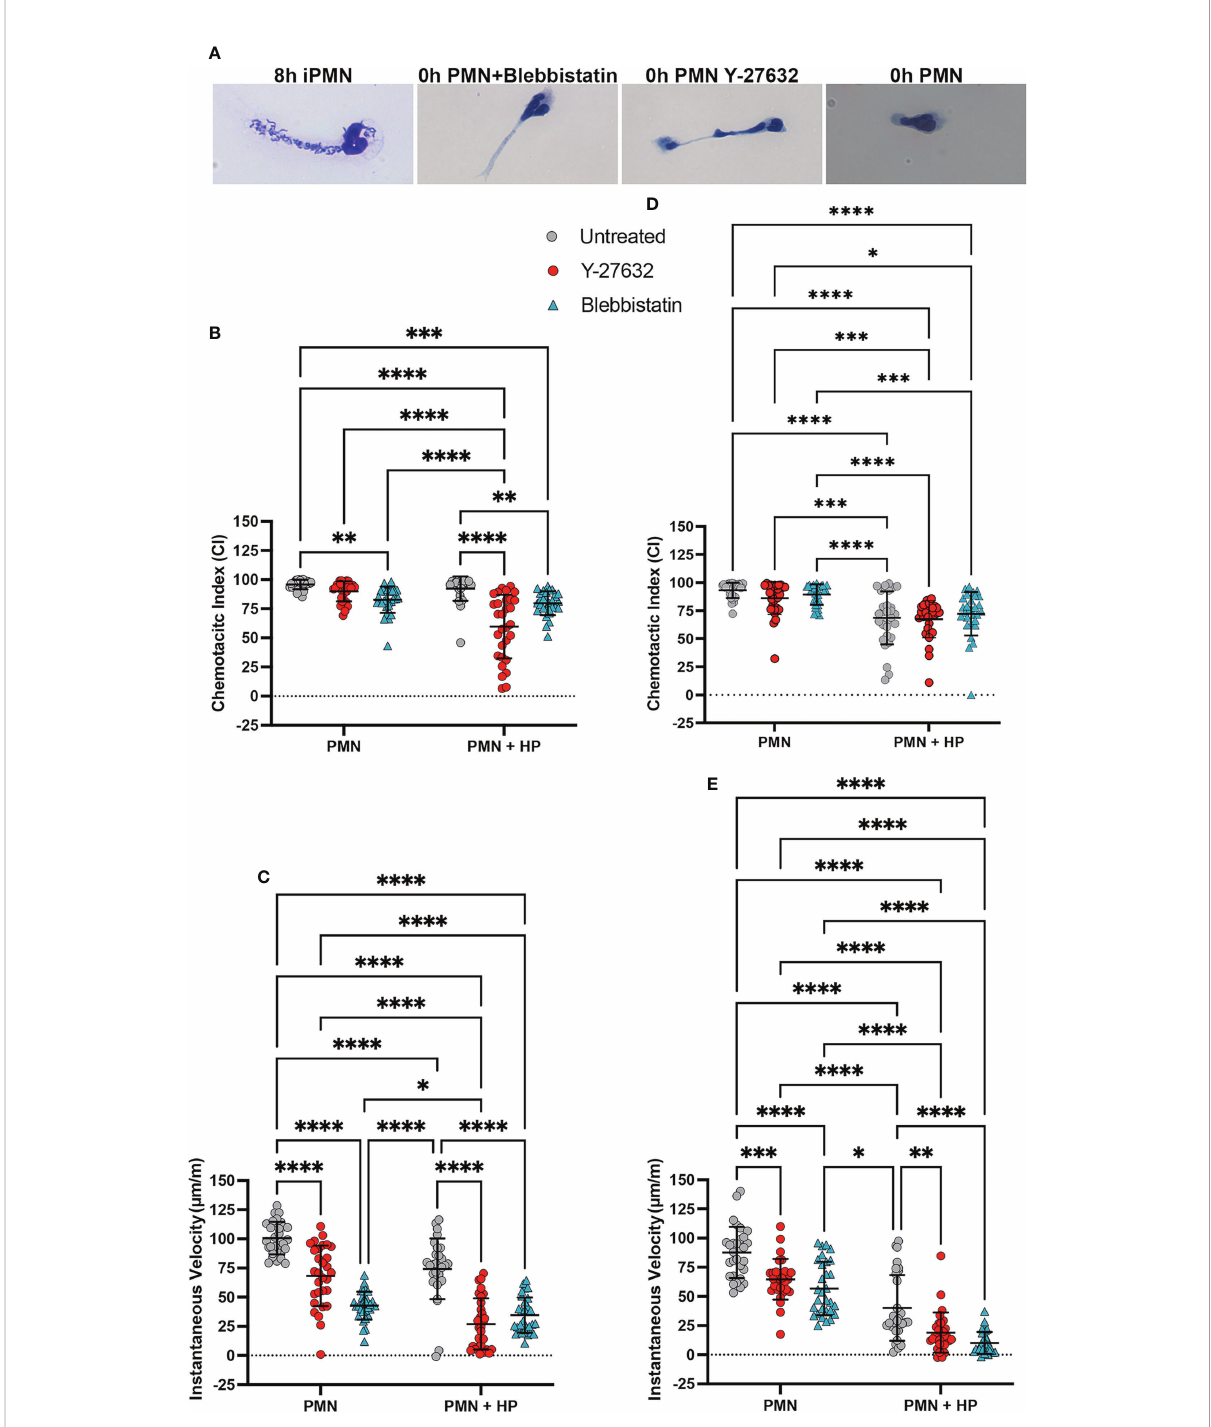
FIGURE 5 Effects of Blebbistatin and Y-27632 on chemotaxis with and without ( H ) pylori infection. (A) Representative images shown Hema-3 stained 8 hour infected PMNs (iPMNs), 0 hour control PMNs, and control PMNs treated with Blebbistatin or Y-27632 migrating toward fMLF in the under- agarose assay. (B – E) EZ-TAXIScan ™ data obtained at 4 hours (B, C) and 8 hours (D, E) . Chemotactic indices (B, D) and instantaneous velocities ( m m/min) (C, E) are shown for untreated control PMNs and cells treated with Blebbistatin or Y-27632 with and without prior H . pylori infection, as indicated. Graphs show the mean ± SD (n=3). Symbols are data for individual cells. Statistical signi fi cance was determined by two-way ANOVA and Tukey ’ s multiple comparisons post-test. * p <0.05, ** p <0.01,** p <0.01, *** p <0.001, **** p <0.0001 for the indicated